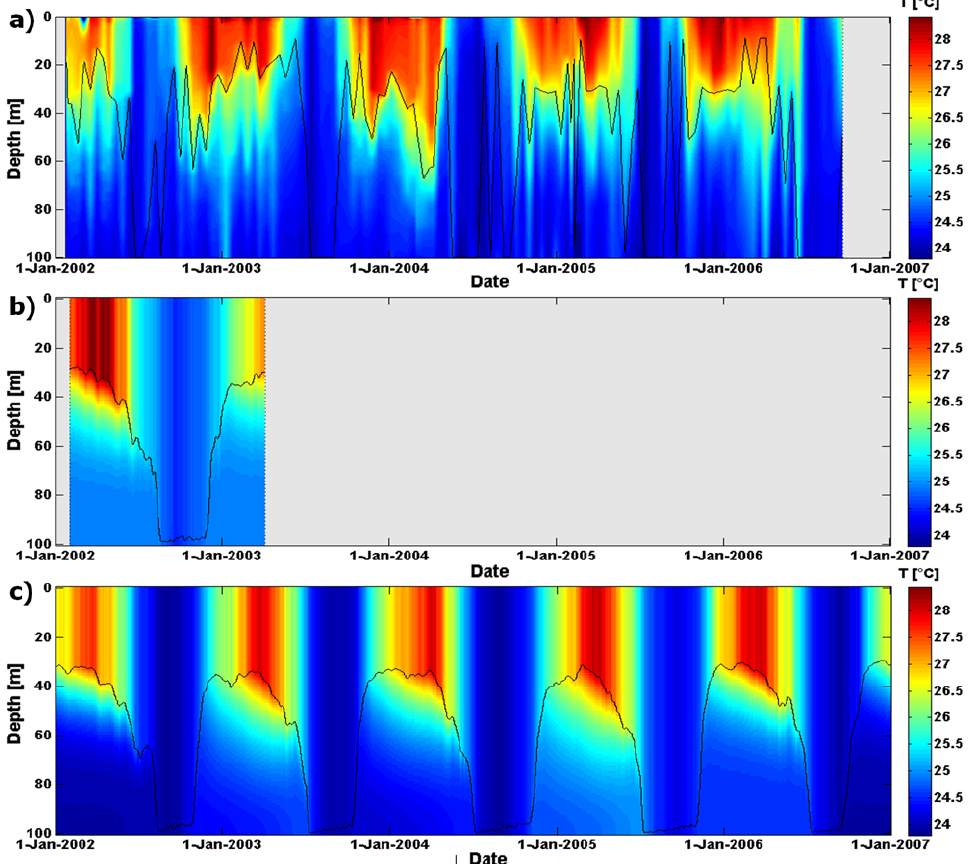
Fig. 9. Lake water temperatures ( ◦ C) at Mpulungu (southern basin of Lake Tanganyika) (a) from observations, (b) as predicted by the AWS- driven FLake-control, and (c) as predicted by FLake-ERA-Interim. The black line depicts the mixed layer depth (Sect. 2.3; weekly mean for the simulations). Results in (c) were obtained with k = 0.09m − 1